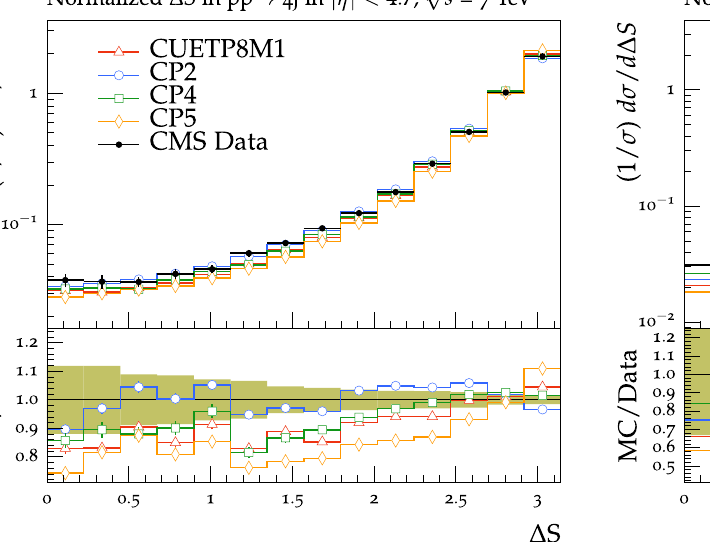
Table 5 Values of σ eff at CMS UE tunes